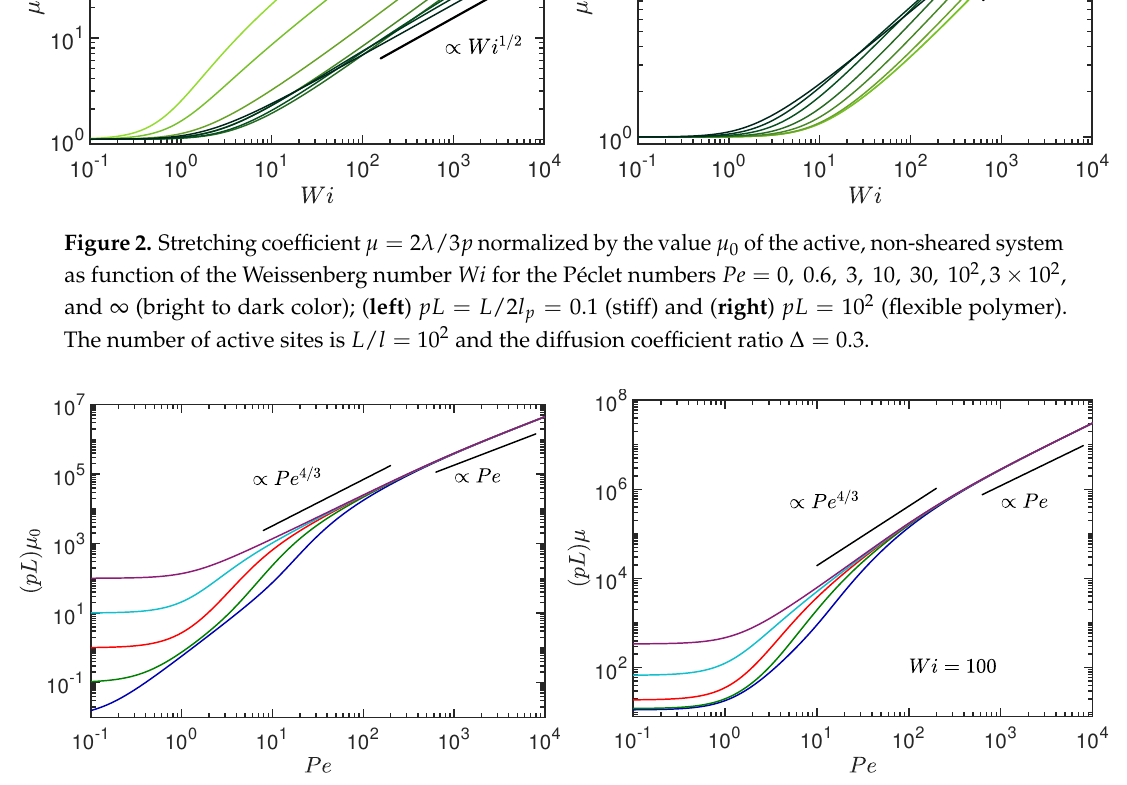
Figure 3. Stretching coefficient µ = 2 λ /3 p as a function of the Péclet number Pe for the stiffness pL = 10 − 2 , 10 − 1 , 10 0 , 10 1 , and 10 2 (bottom to top). The Weissenberg numbers are ( left ) Wi = 0 [52] and ( right ) Wi = 10 2 . The number of active sites is L / l = 10 2 and ∆ =